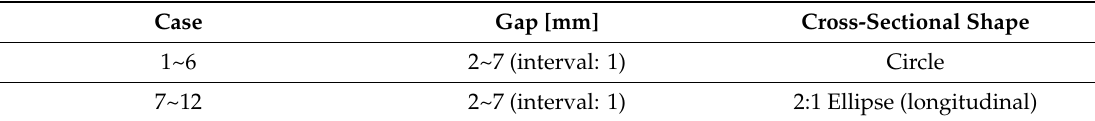
Figure 11. Velocity profile at the outlet with transverse obstacles: ( a ) circles, ( b ) 2:1 longitudinal ellipses. Table 5. Computational